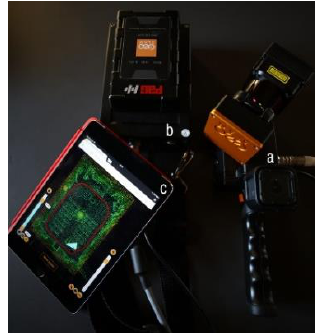
Figure 4. The ZEB-Revo RT system: (a) the handheld